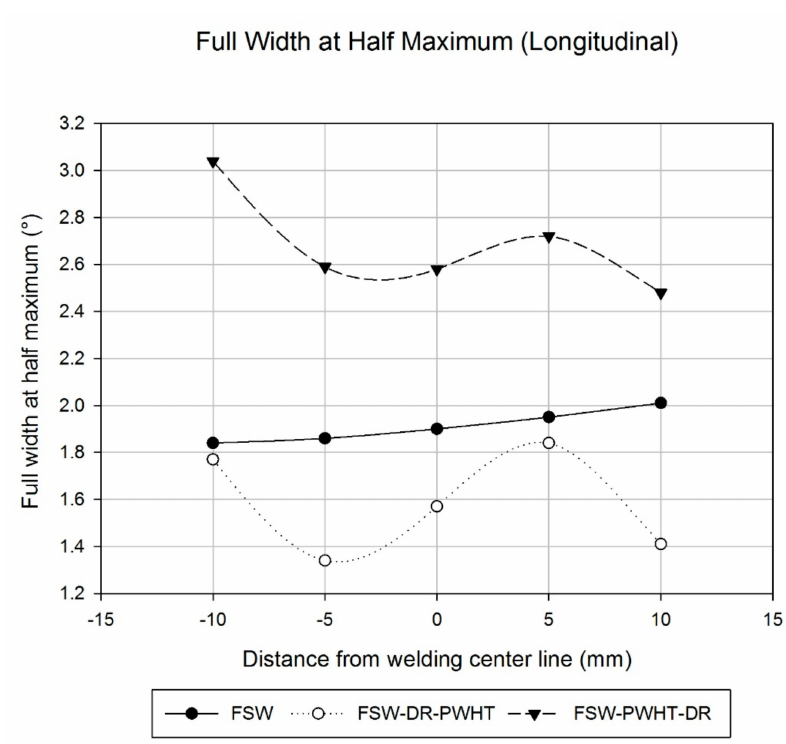
Figure 12. Full width at half maximum value in the longitudinal